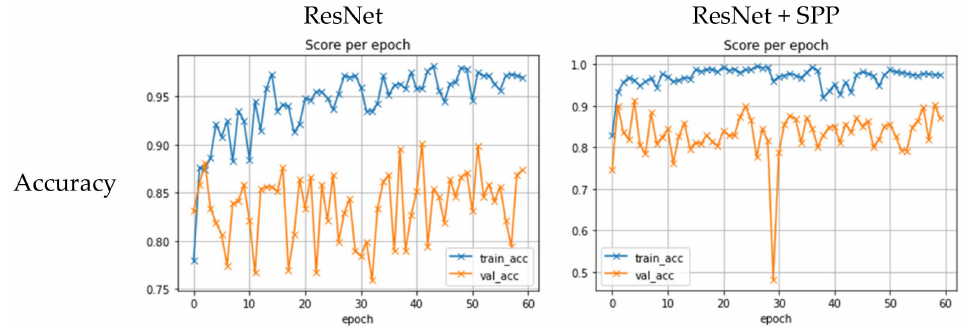
Figure 13. Performance comparison analysis between ResNet and ResNet +